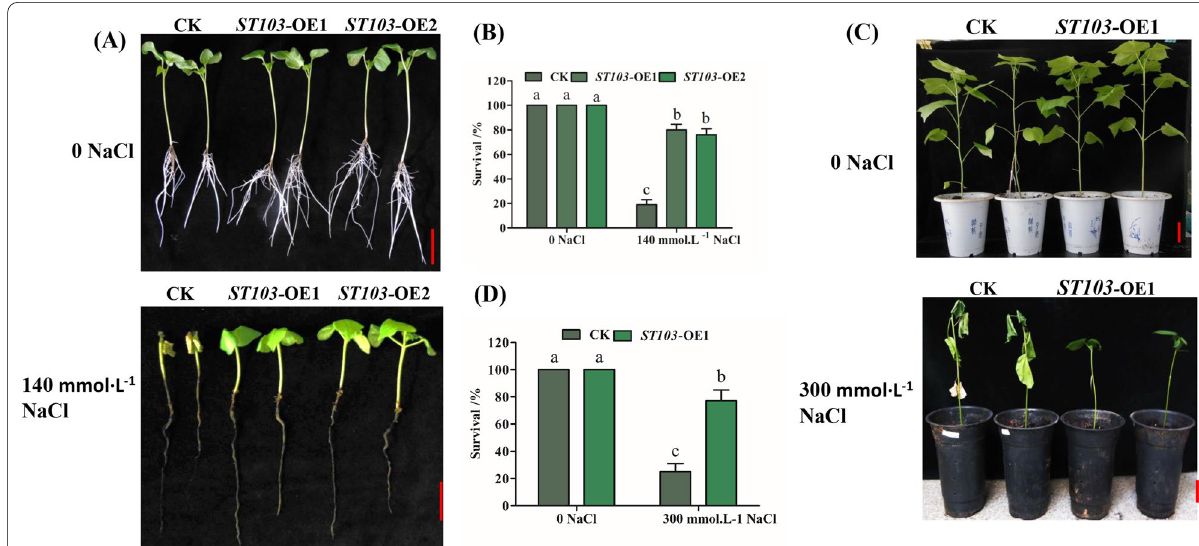
Fig. 2 The overexpression of ThST103 enhances the salt tolerance of 2 weeks old cotton seedling grown in the hydroponic medium and in soil under saline environment. A , B The seeds germinated for 4 days in soil, relocated to hydroponic culture for a week and exposed to 140 mmol NaCl for 3 further days. Bar 4 cm. Values are mean SD (7 plants per replicate, four replicates per treatment). Different letters denote significant = ± differences ( P < 0.05) from Duncan’s multiple range tests . C Plants grown in soil for 20 days and treated with 0 NaCl or 300 mmol another 10 days. Bar 4 cm. D Survival rate of seeds germinated in the soil for 20 days and then treated with 0 and 300 mmol = 10 days. Values are mean